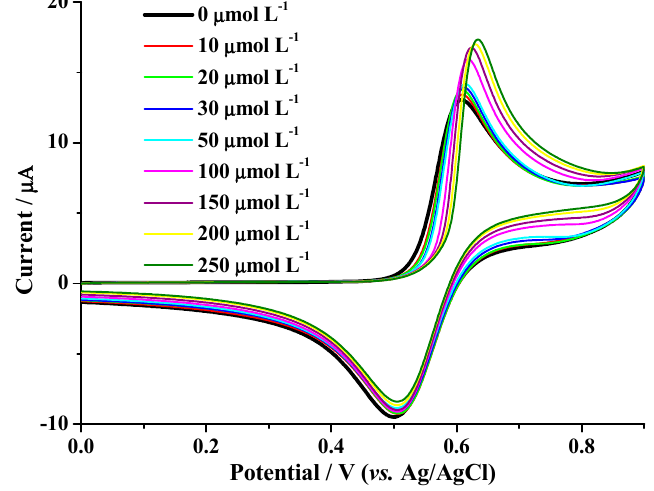
Figure 4. Cyclic voltammetry of a 1 mmol L − 1 KI solution in the presence of different amounts of reduced glutathione. Scan speed, 0.05 V s − 1 ; Pt used as working electrode, graphite used as counter electrode.